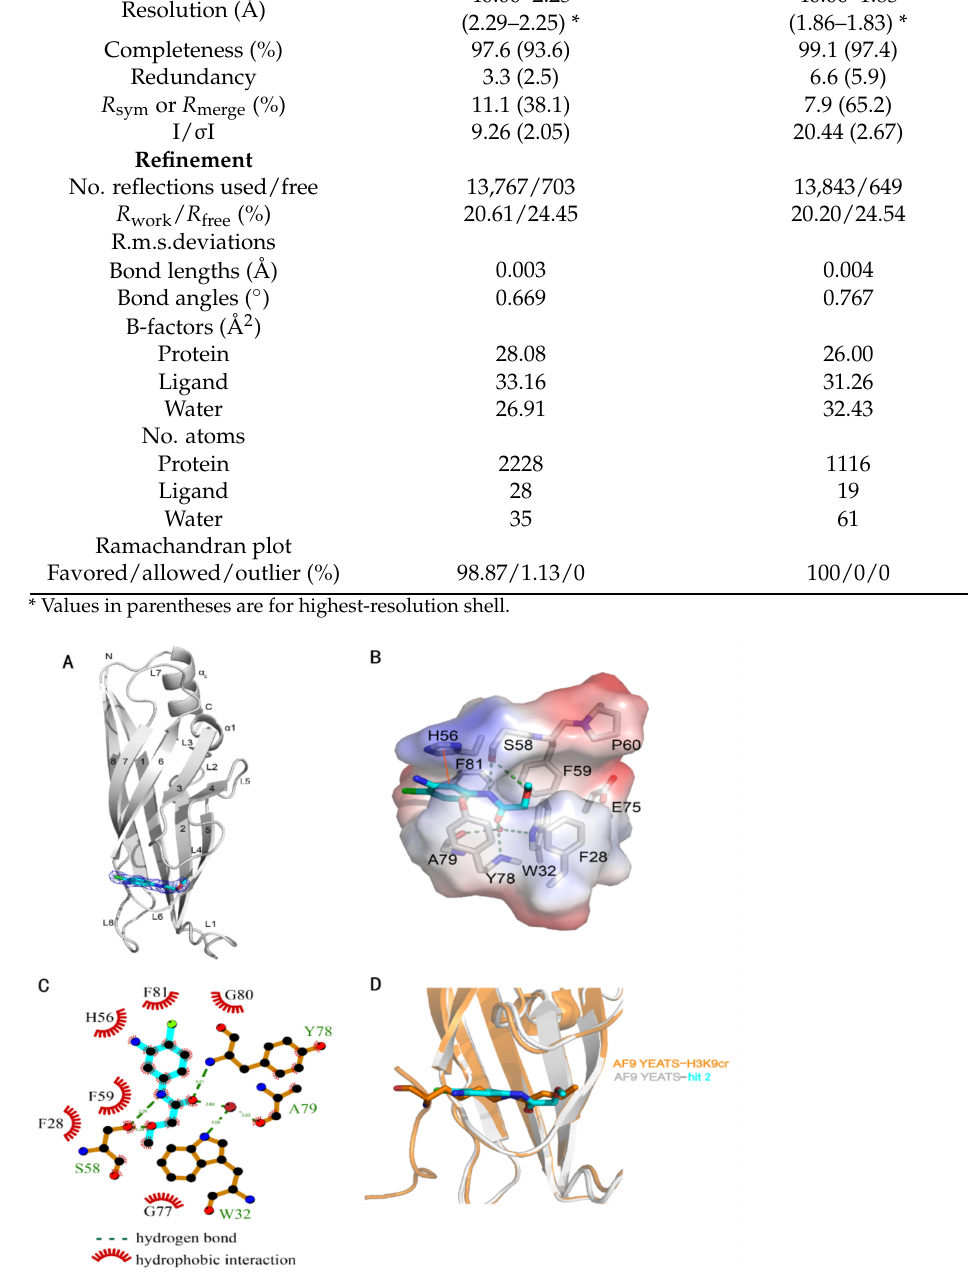
Figure 2. Crystal structure of the AF9 YEATS domain in complex with hit 2 . ( A ) Ribbon diagram of the structure of AF9 YEATS in complex with hit 2 (carbon atoms in cyan). The 2Fo–Fc electron density map of 2 was contoured at 1 σ . ( B ) Detailed interactions between 2 and proximal residues of AF9 YEATS with hydrogen bonds (green dashed line) and π - π interactions (orange solid line) are delineated. ( C ) LIGPLOT program illustrating the contacts between AF9 YEATS domain and 2 . ( D ) Superimposition of the crystal structures of the AF9 YEATS in complex with 2 or crotonylated H3K9 (PDB code: